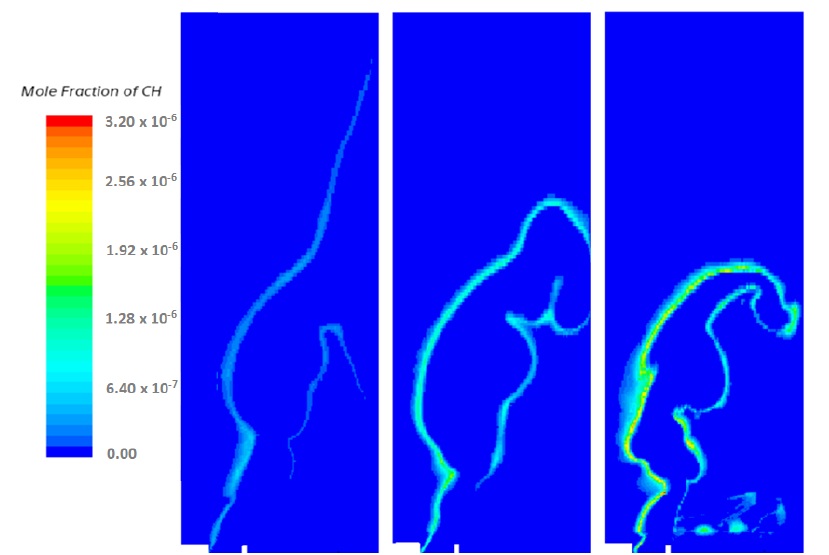
Figure 11. Instantaneous mole fraction of CH. ( Left ) 20/80; ( Centre ) 40/60; ( Right ) 60/40 (vol%) methane/ammonia blends under stoichiometric conditions.